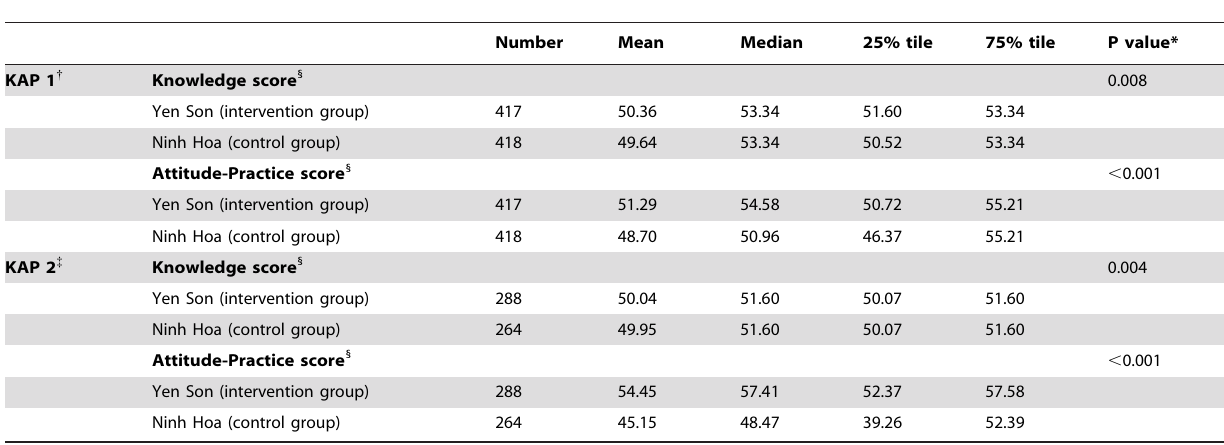
Table 4. Scores of knowledge and attitude-practice relating to avian influenza.